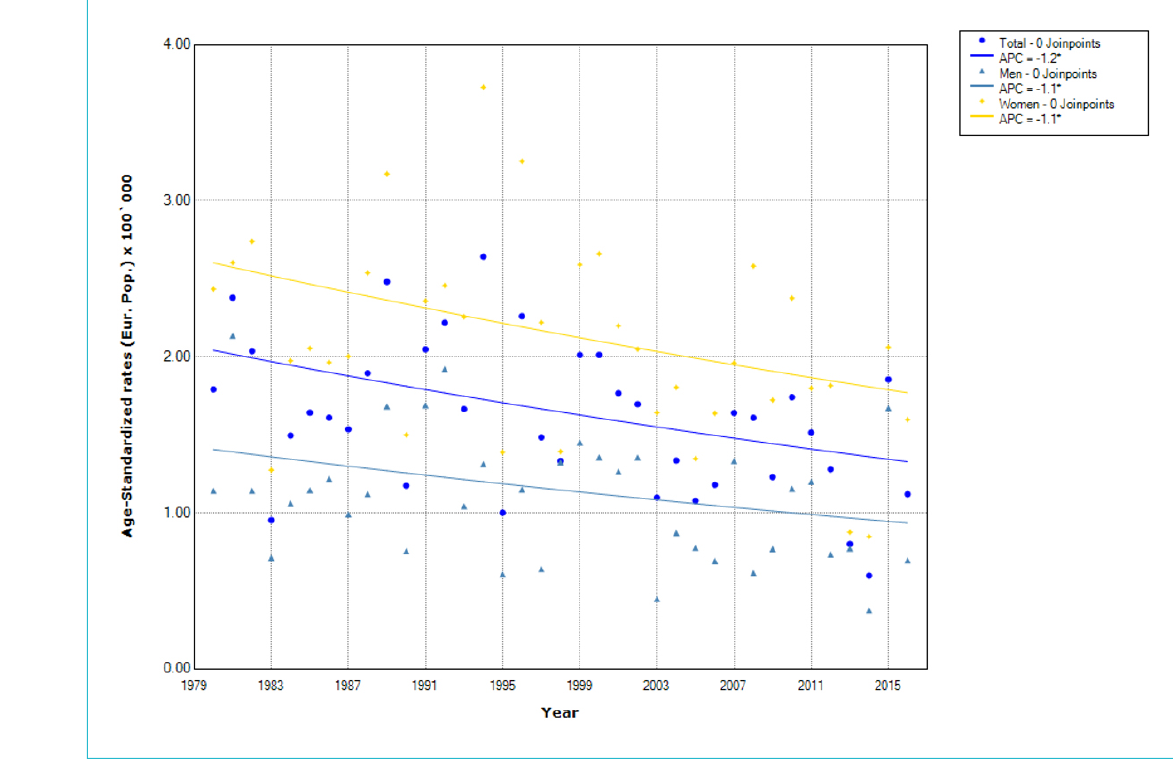
Figure 2: Trends in non-papillary thyroid cancer incidence by sex. Canton of Zurich 1980–2016. APC (annual percentage change). Age-stan- dardised rates (European